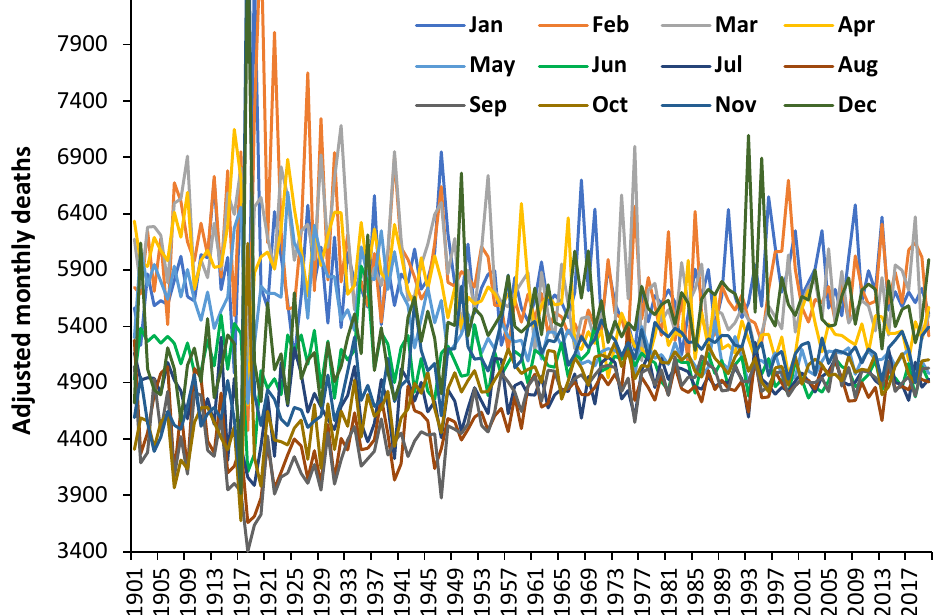
Figure 3. Trend in adjusted monthly deaths in Denmark. Monthly deaths first adjusted to give equal days per month and then adjusted to give an annual total equal to the maximum achieved in 1995. The Y -axis is truncated at 8400. Deaths per month merge over time with June and July showing the least change. The seven months June to December show an increase over time, while the five months January to May reduce over time. February, November, and December are the most volatile. Not only have monthly deaths converged but